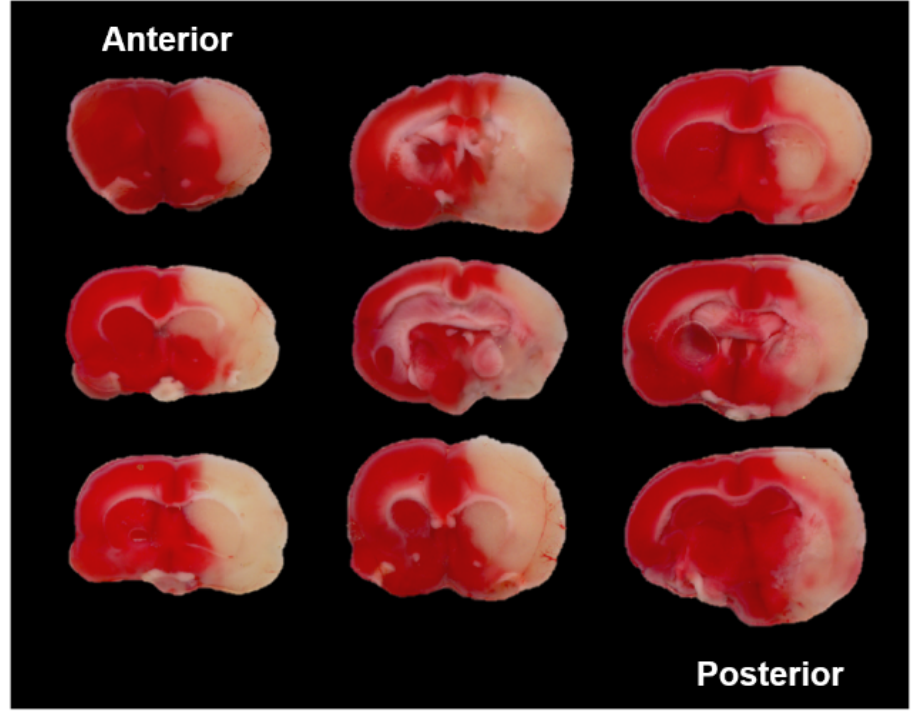
Figure 3. Coronal section images of TTC staining of a MCAO rat brain. Infarct areas (MCAO-lesioned side of the brain) were stained as white.